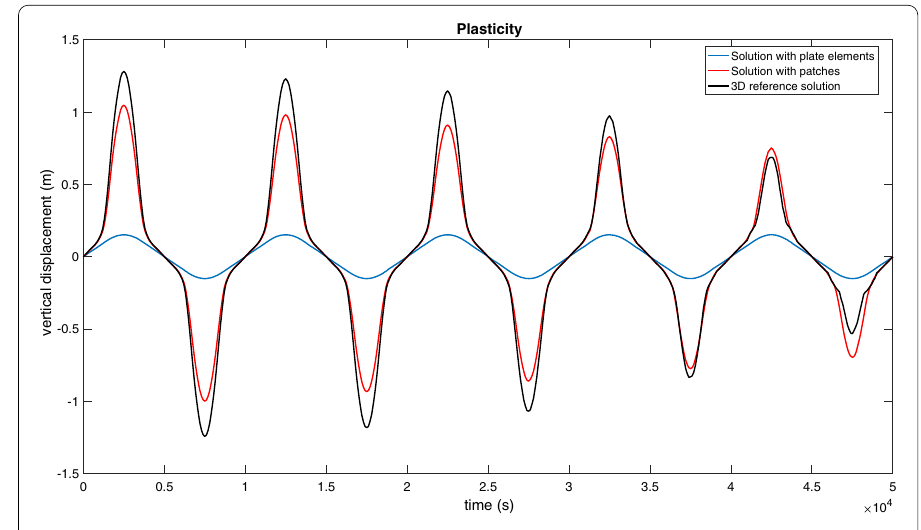
Fig. 21 Vertical elasto-plastic displacement evolution in time at the right